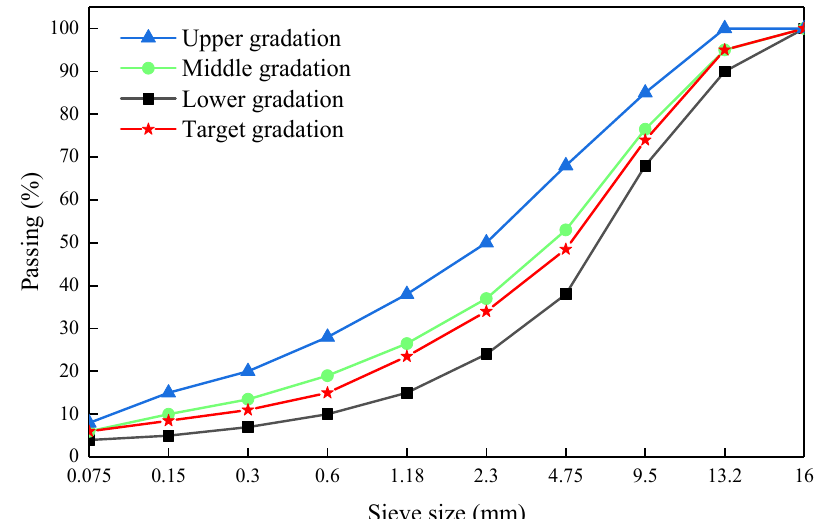
Figure 1. Gradation curve of mixture.